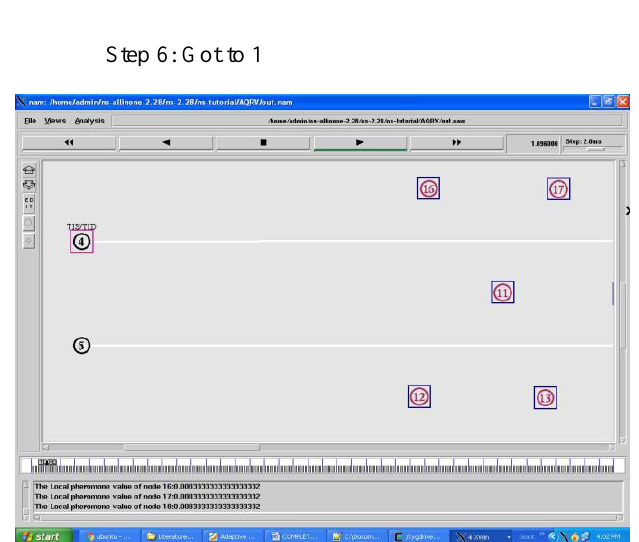
Figure 5: RSR node